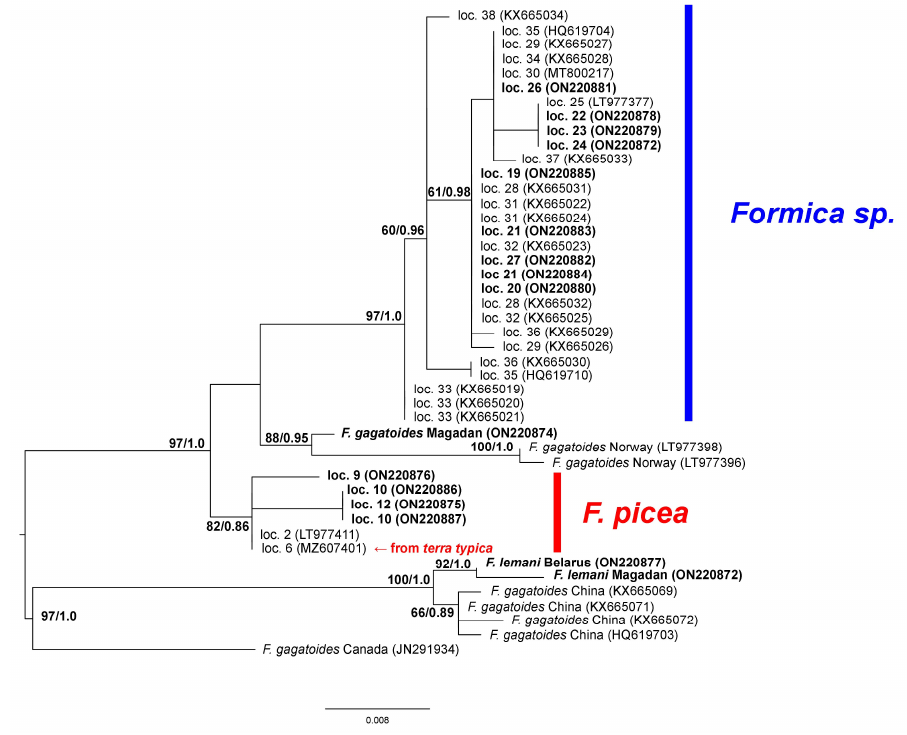
Figure 3. Phylogenetic tree constructed using cox1 sequences. Numbers near branches indicate ML bootstrap support/Bayesian posterior probabilities. GenBank accessions given in parentheses; sequences obtained in this study are shown in